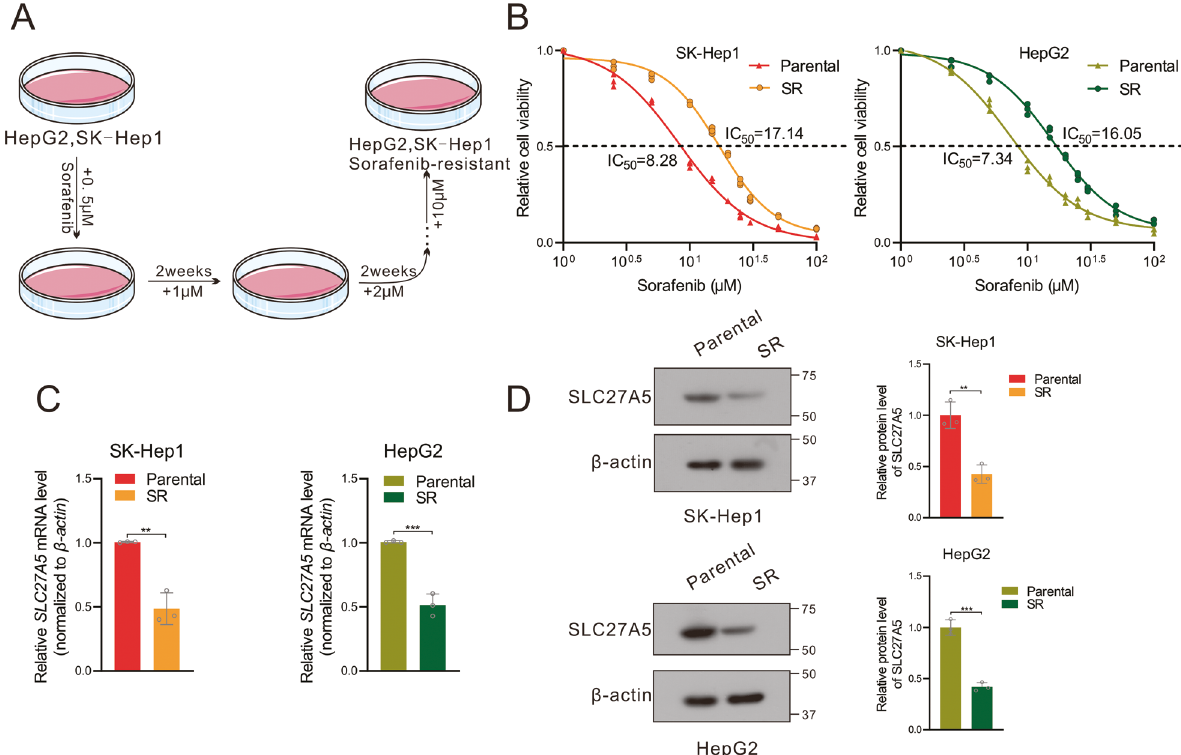
Fig. 1 SLC27A5 expression is downregulated in the sorafenib-resistant hepatocellular carcinoma cells. A Schematic diagram of the construction of the sorafenib-resistant cells. B The IC 50 values of sorafenib-sensitive and sorafenib-resistant SK-Hep1 and HepG2 cells that were incubated with sorafenib in a concentration gradient manner. C , D The mRNA ( C ) and protein ( D ) expression of SLC27A5 in sorafenib- sensitive and sorafenib-resistant HCC cells. SR sorafenib resistant. All data are presented as mean ± SD ( n = 3). Statistical signi fi cance was calculated using two-tailed unpaired Student ’ s t- test. * p < 0.05, ** p < 0.01, *** p <